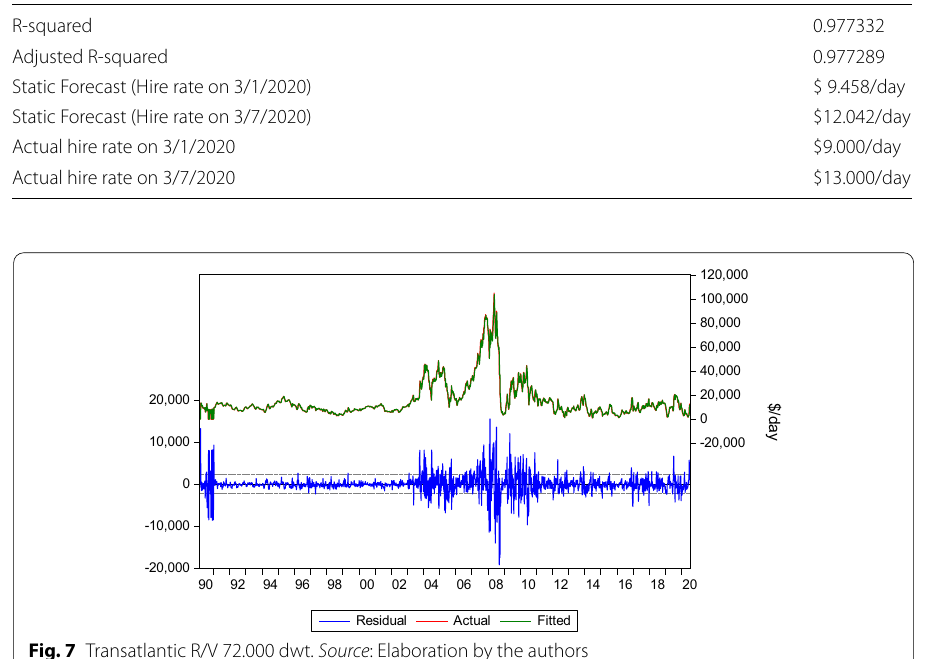
Fig. 7 Transatlantic R/V 72.000 dwt. Source : Elaboration by the